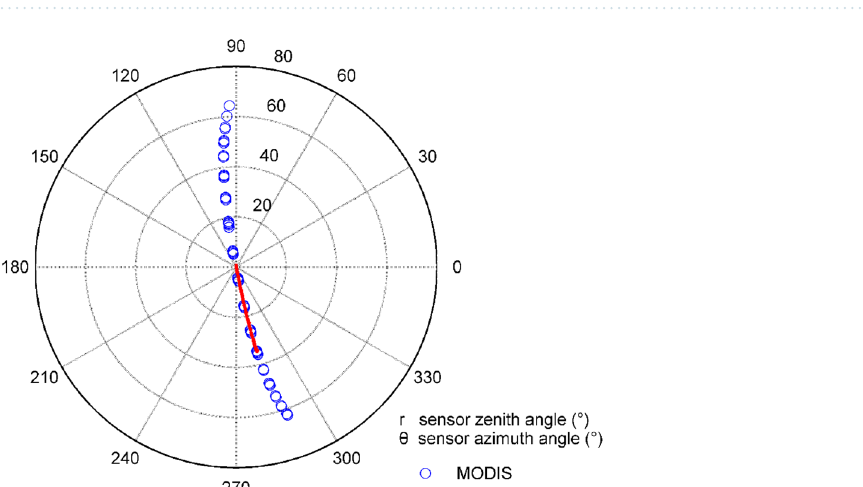
Figure 4. Sensor geometries of CCD1 and MODIS.